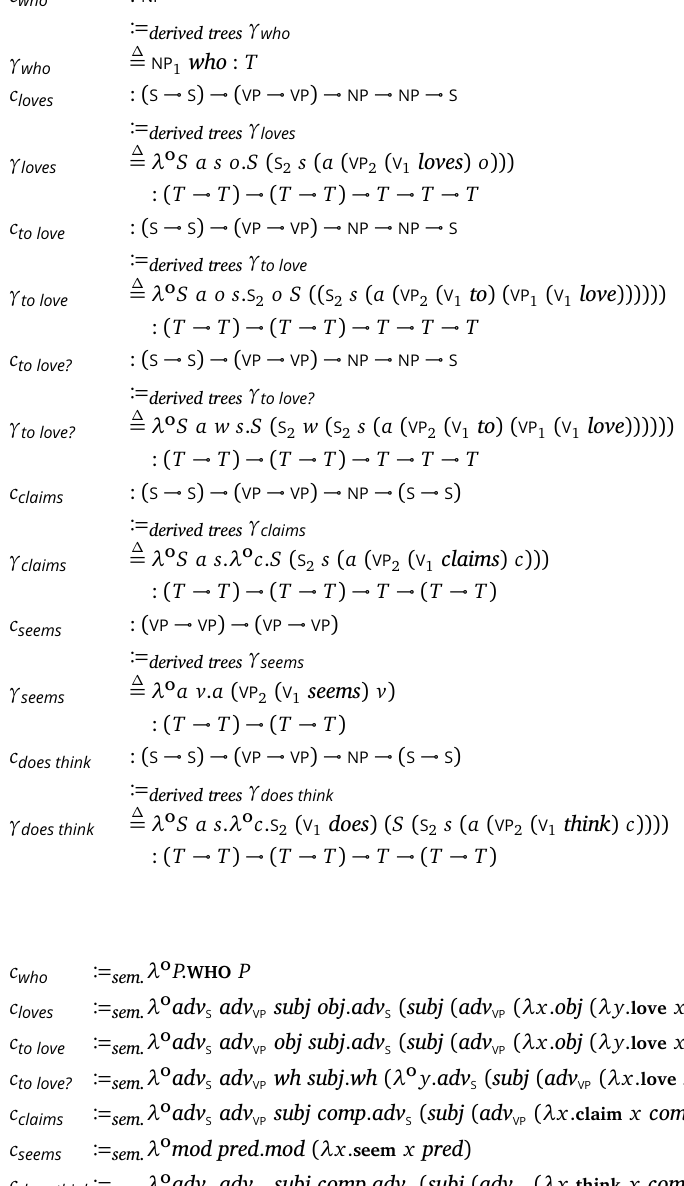
Interpretation by G derived trees